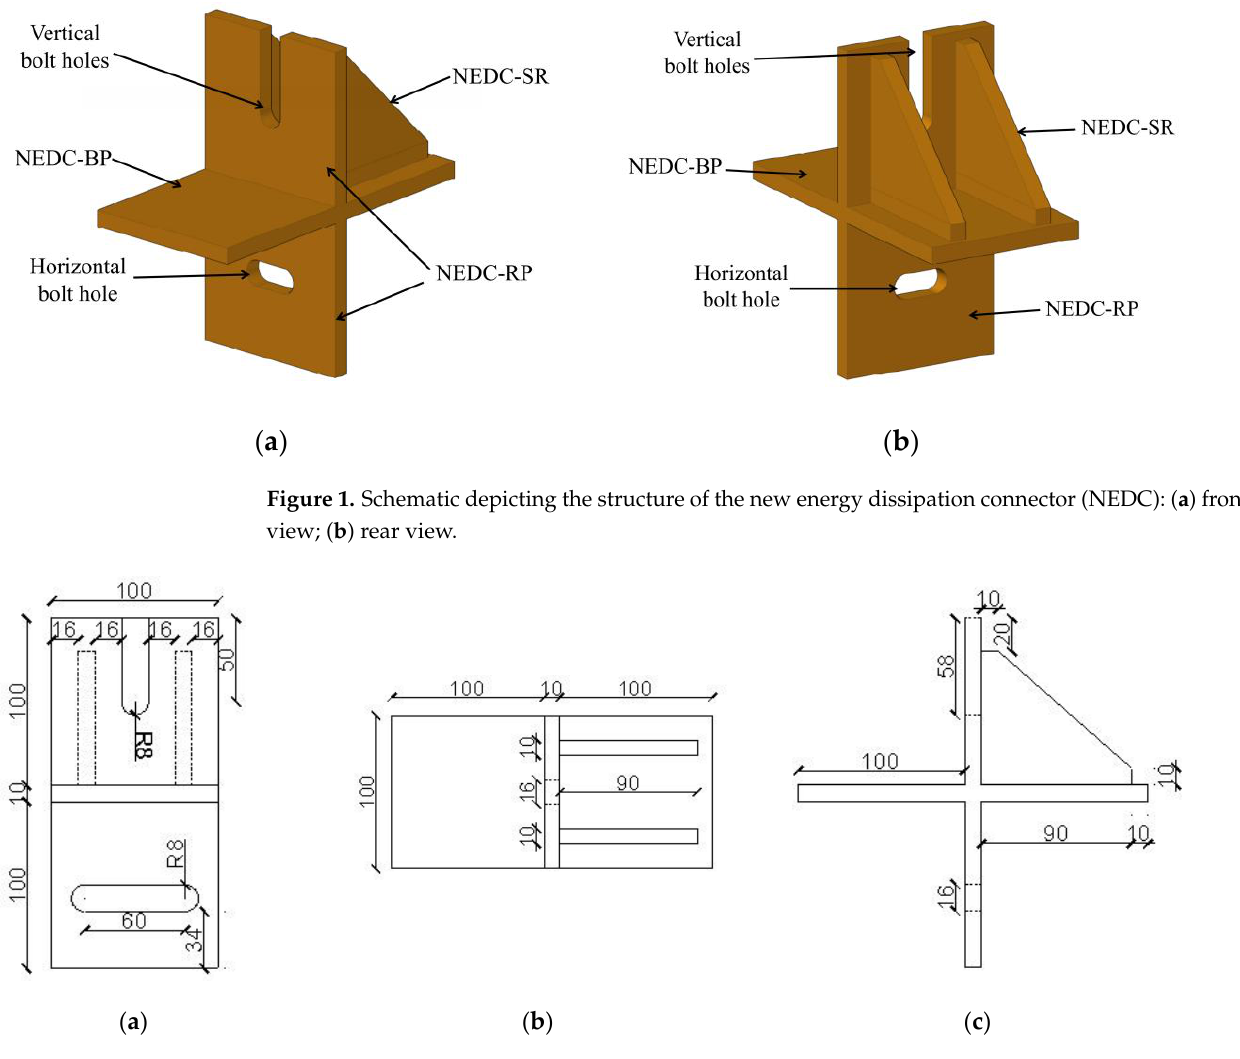
Figure 2. Dimensional drawing of the new energy dissipation connector: ( a ) Front View; ( b ) Overhead view; ( c ) Side view.